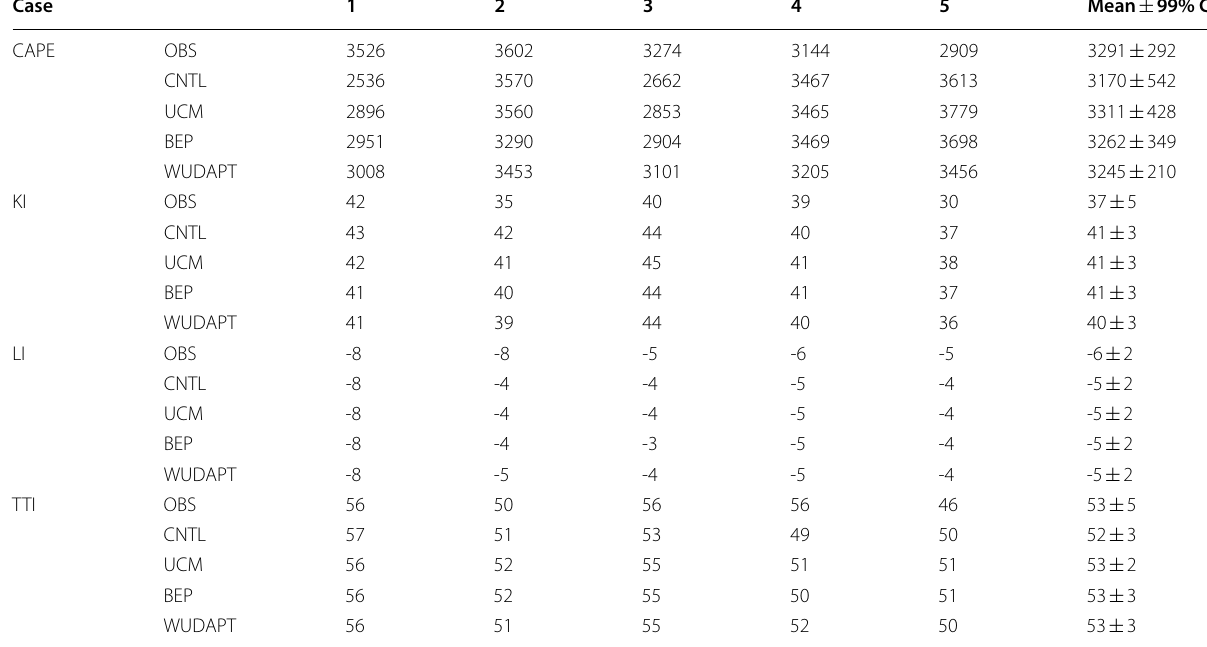
Table 5 Mean and 99% confidence interval (CI) of stability indices for various experiments along with the observation